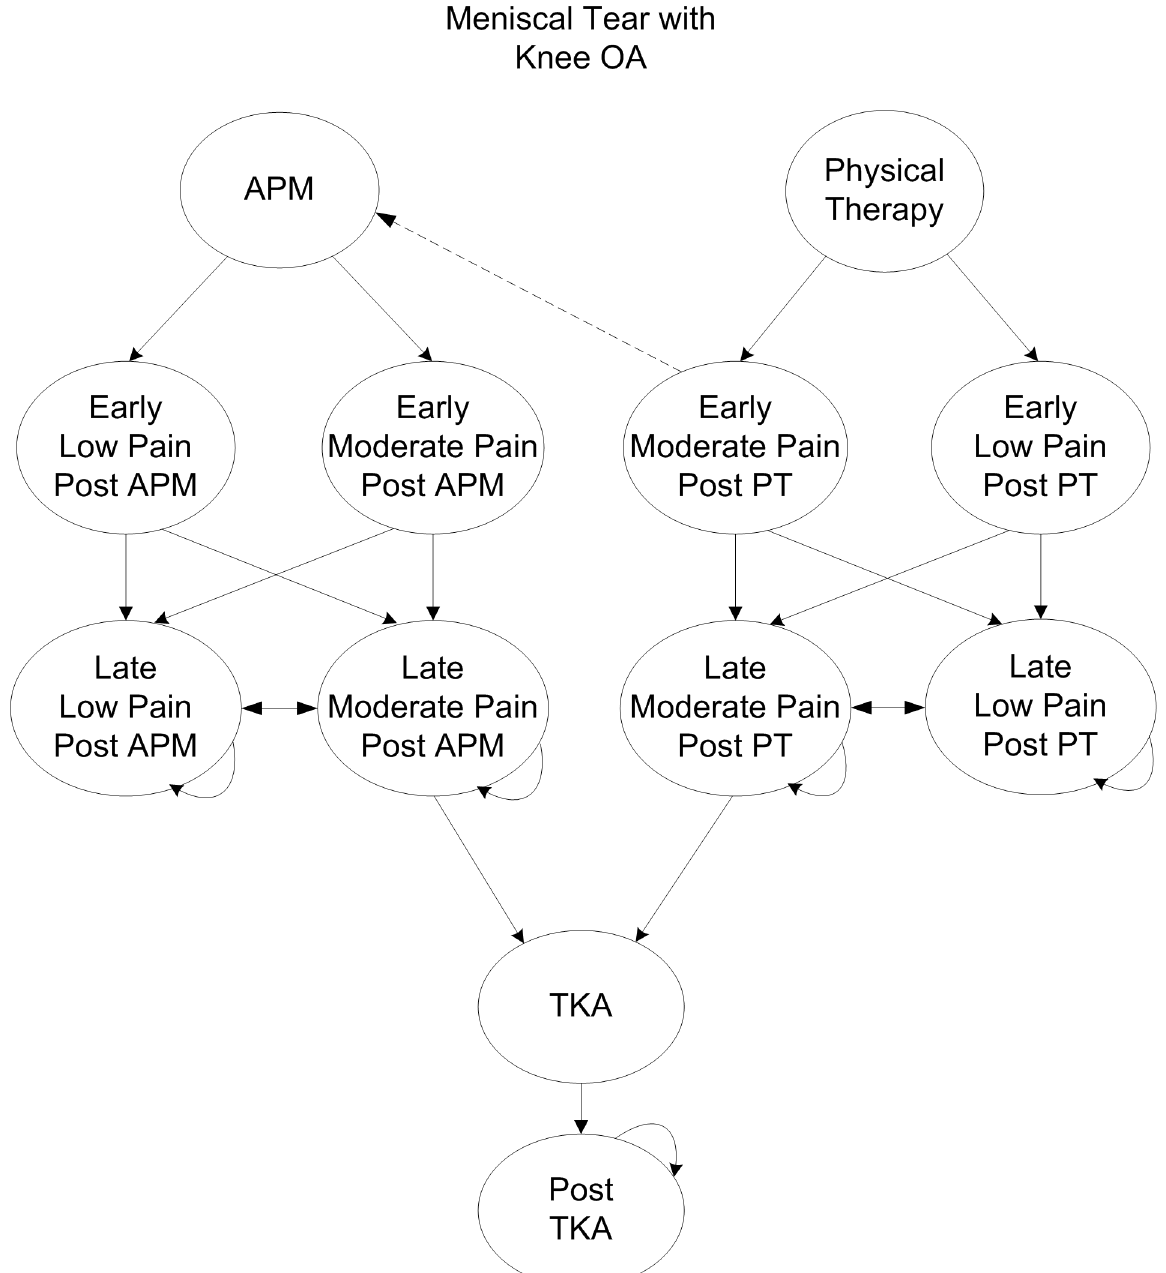
Fig 1. Model Structure for the Treatment of Meniscal Tear. Fig 1 describes the model structure used for evaluating the cost-effectiveness of three strategies used for the treatment of MT in the presence of knee OA: 1) PT, 2) PT with referral for APM in those patients with persistent pain after PT, and 3) APM for all patients. Straight arrows describe a subject ’ s transition from one health state to another. Curved arrows indicate the possibility of cycling within one health state given no change in pain status. Health states were stratified by KL grade. Subjects who received a particular treatment transitioned through early and late, and low or moderate pain states depending on treatment efficacy and knee OA progression. All subjects in the ‘ Delayed APM ’ strategy who transitioned to early moderate pain transitioned to APM with probability of 1. Subjects in late pain could transition to